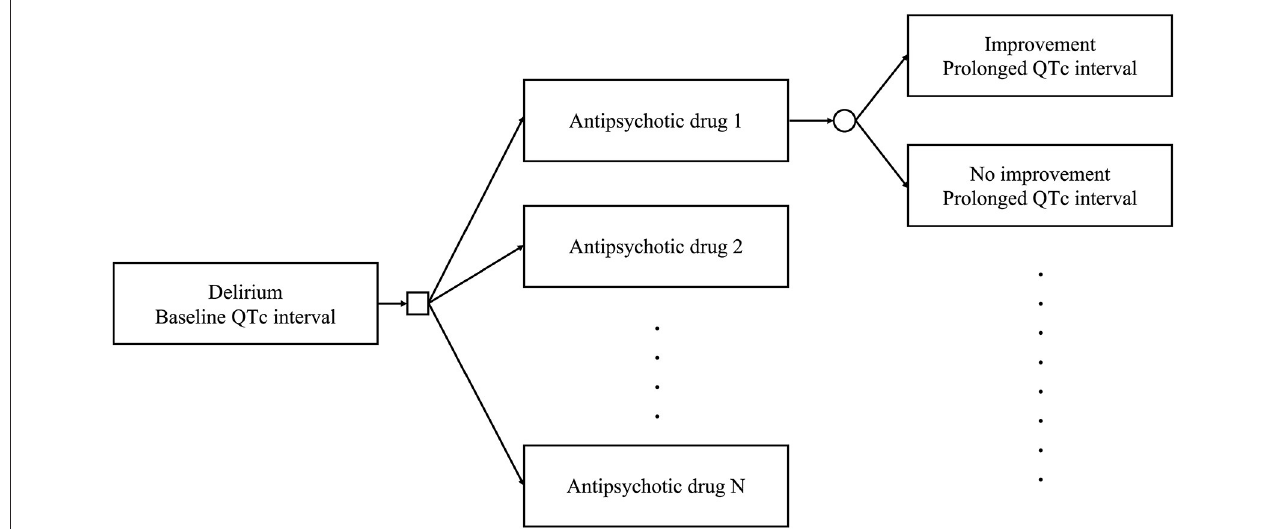
FIGURE 1 | Decision tree used in this study. Clinicians can select an antipsychotic drug among multiple options to treat delirium. The square represents a decision node. The delirium status improves or does not. The QTc interval changes according to the effects of the selected antipsychotic drug. The circle represents a chance node.